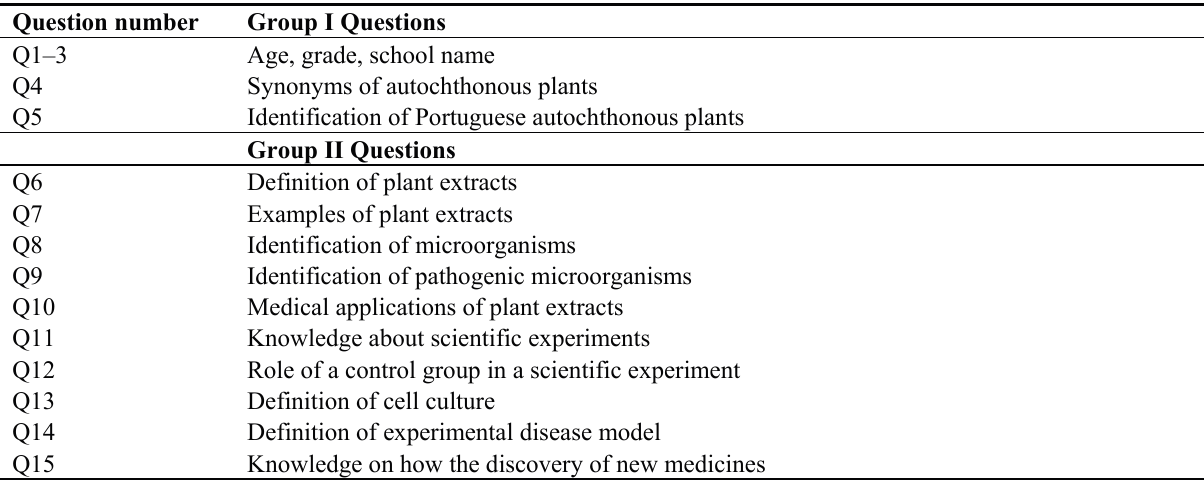
Table 2. Questions used in the pre/post-test to investigate students’ progress in learning the themes developed in this